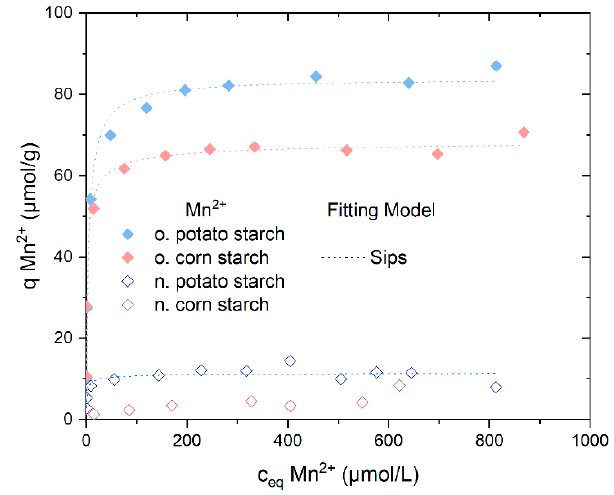
Figure 7. Adsorption isotherms capacity for Mn 2+ from MnSO 4 solution presents the Sips isotherm model fits, the Langmuir and the Dubinin–Radushkevich fitting models were presented in Figure S16. With n. potato starch is shown in blue, n. corn starch in red, o. corn starch in pink, and o. potato starch in light blue. Table 4. Fitting parameters for the adsorption of Mn 2+ from MnSO 4 solution onto n. potato starch,